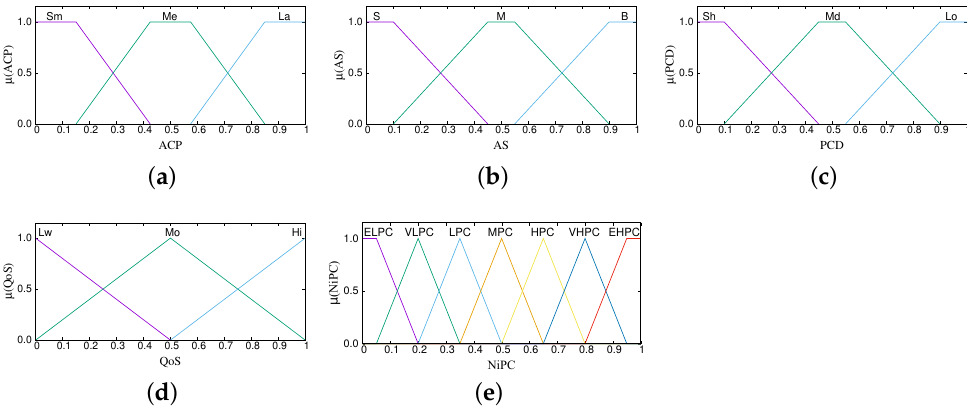
Figure 6. Membership functions of FS-ANVPC. ( a ) Available Computing Power, ( b ) Available Storage, ( c ) Predicted Contact Duration, ( d ) Quality of Service, and ( e ) Neighbor i Processing